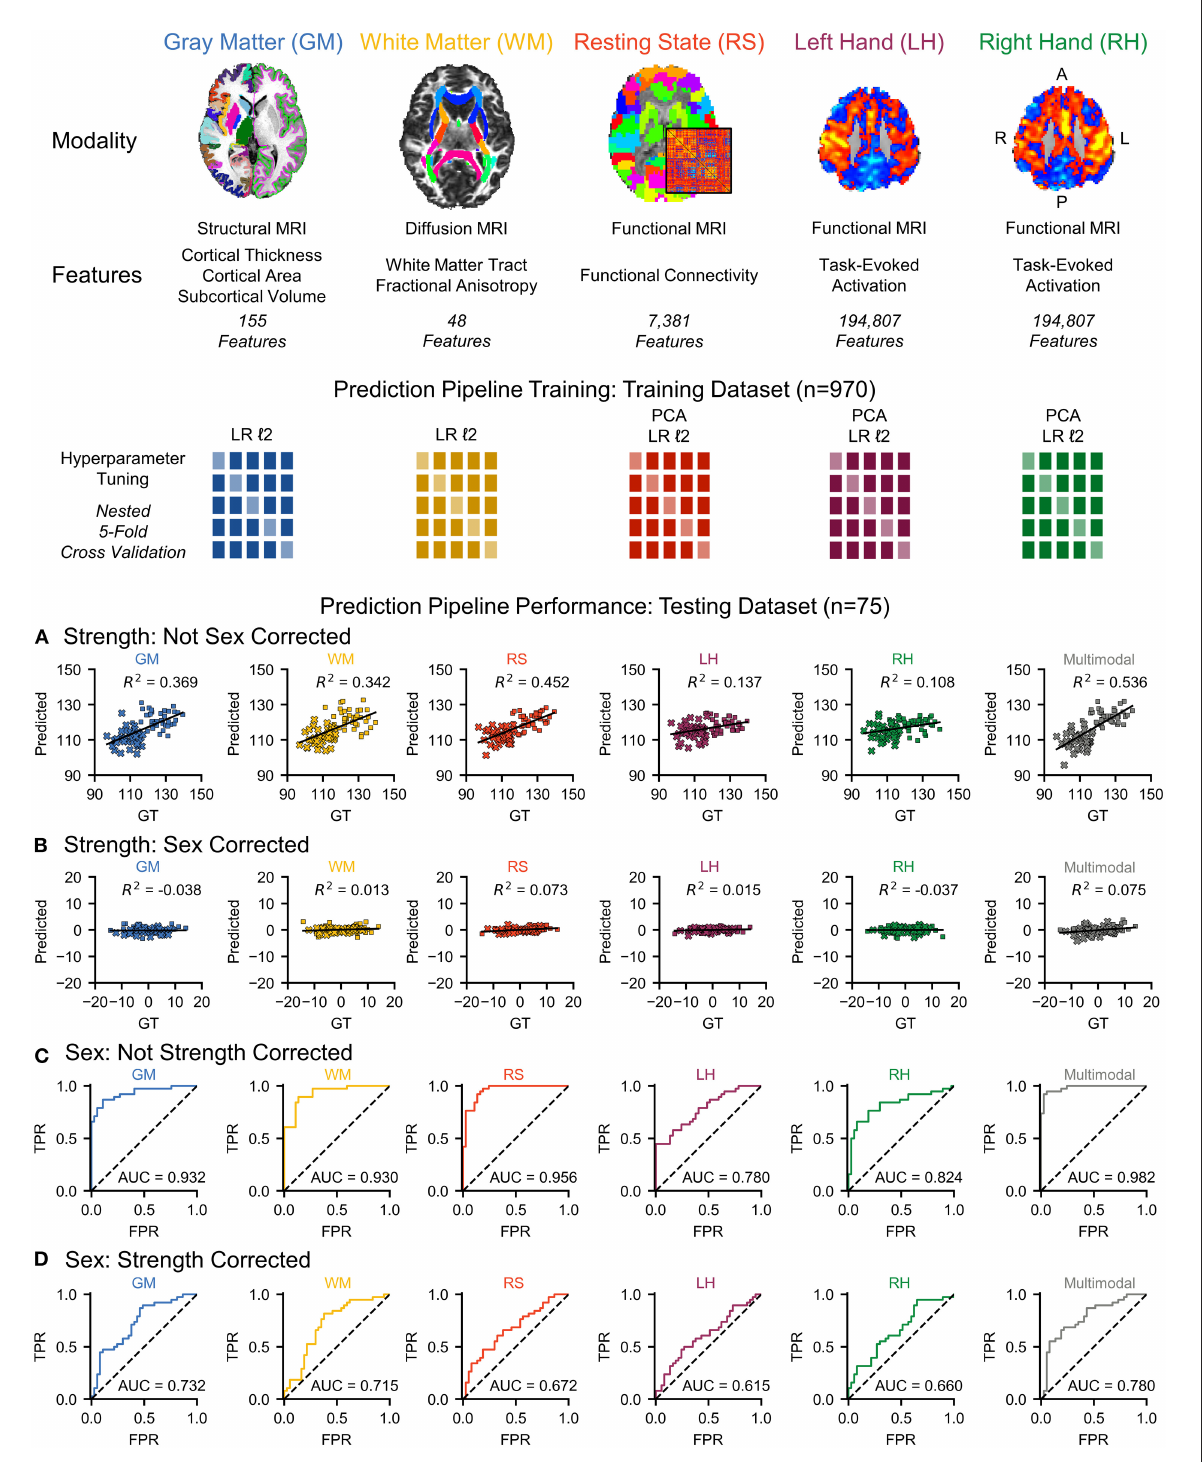
FIGURE1 We used multimodal brain MRI and grip strength scores to characterize and quantify the brain’s contribution to strength through multivariate predictive modeling. Multimodal brain MRI provides measures on gray matter (GM) morphometry, white matter (WM) fractional anisotropy, resting state (RS) functional connectivity, and left hand (LH) and right hand (RH) motor task activation. We trained a prediction pipeline for each MRI modality on the training dataset ( n = 970) using non-sparse ( ℓ 2) linear regression (LR) models with principal component analysis (PCA) for dimensionality reduction, when applied, and nested five-fold cross-validation for hyperparameter tuning. We then used stacked ensembles of the prediction pipelines to combine the first-level models into second-level multimodal models. (A) Each MRI modality and a multimodal model